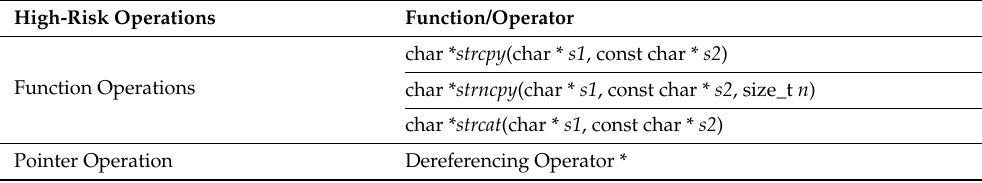
Table 1. List of High-risk